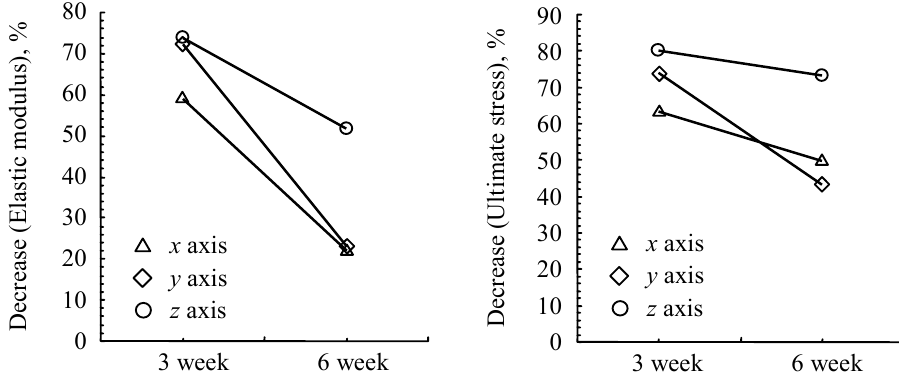
Fig. 6 The decrease in mechanical properties of the OVX rat models compared to the controls at 3 and 6 weeks. x -, y - and z -axis are mediolateral, anteroposterior and craniocaudal orientations, respectively.